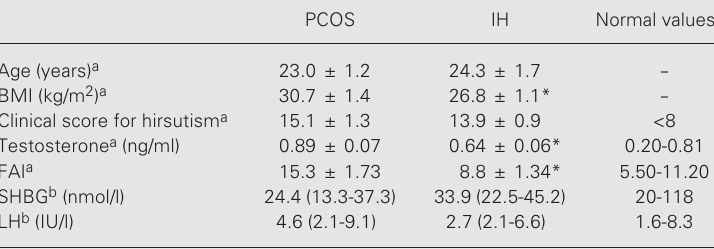
Table 2. Clinical and hormonal data for hirsute patients with polycystic ovary syn- drome (PCOS) and idiopathic hirsutism (IH). PCOS IH Normal